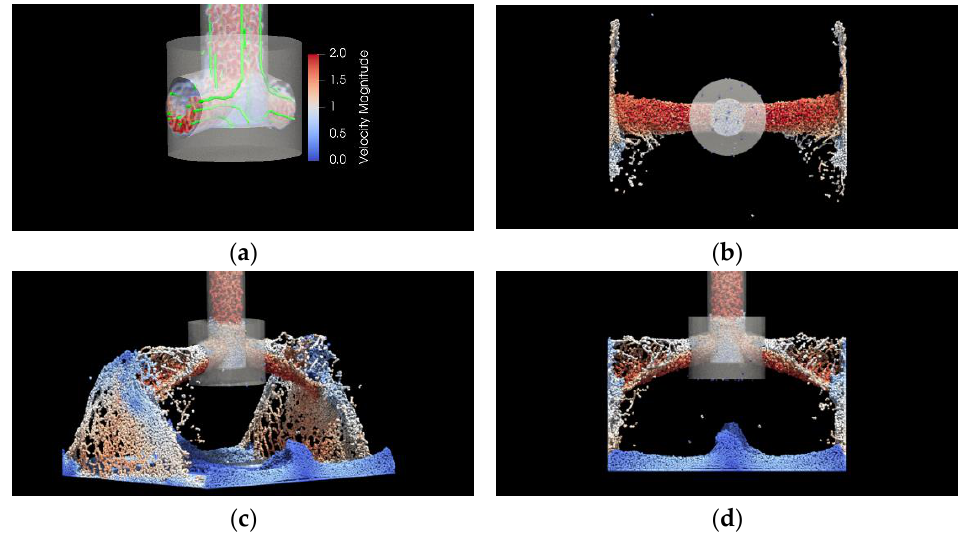
Figure 10. Numerical results for the flat bottom SEN model, FB. ( a ) the flow streamlines; ( b ) a projection onto the XY plane, viewed from the bottom of the SEN; ( c ) perspective view of the jets; ( d ) a projection onto the YZ plane.